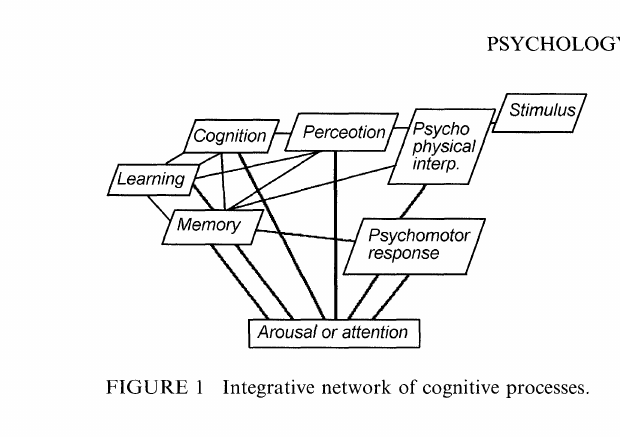
Arousal or attention FIGURE Integrative network of cognitive